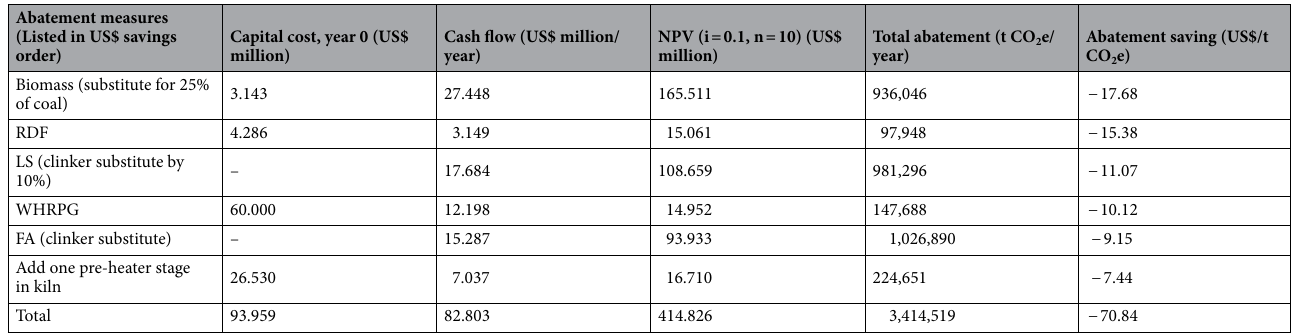
Table 2. Marginal abatement cost of mitigation measures 67